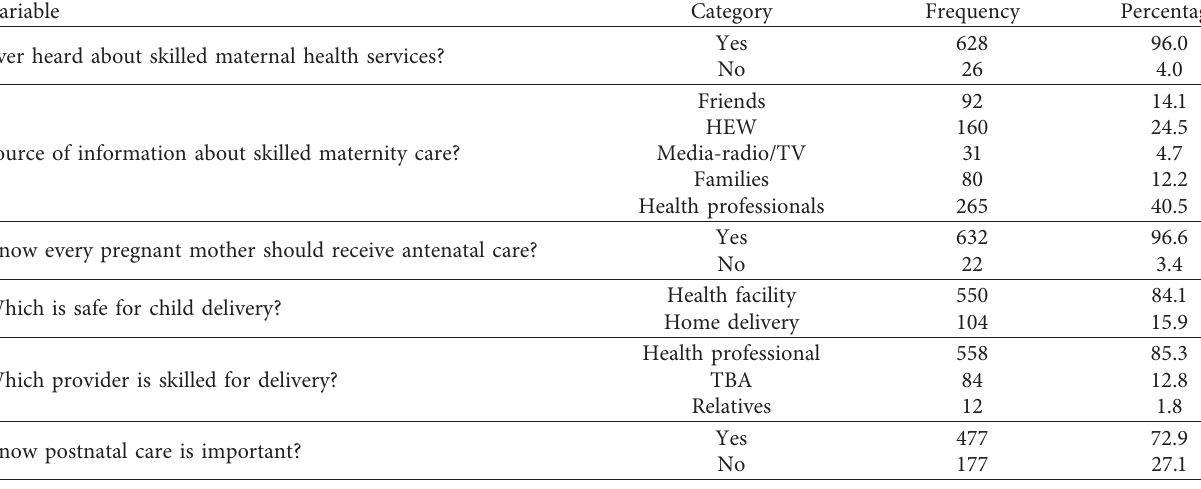
Table 2: Knowledge towards skilled maternal healthcare among study